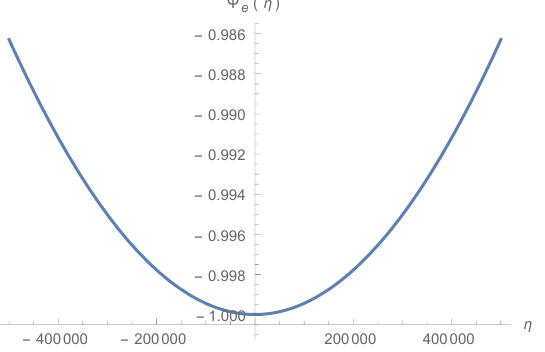
Figure 15. Time evolution of Ψ e in the Jordan frame for the initial conditions Φ e ( 0 ) = − 10 − 2 , Ψ Φ (cid:48) ( 0 ) = 0, Ψ (cid:48) ( 0 ) = 0. The background evolution is the one obtained by assuming the e ( 0 ) = − 1, e e same initial conditions as mentioned in the caption of Figure